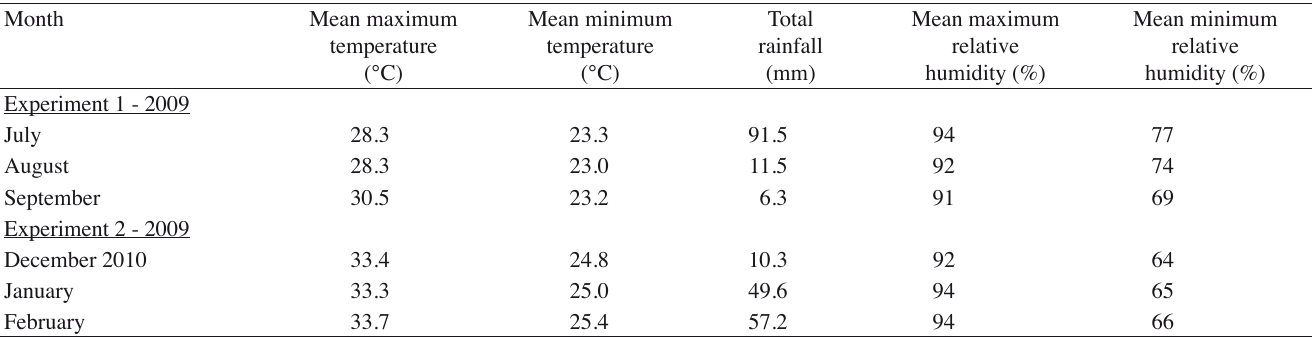
Table 1 - Climatological data during experimental